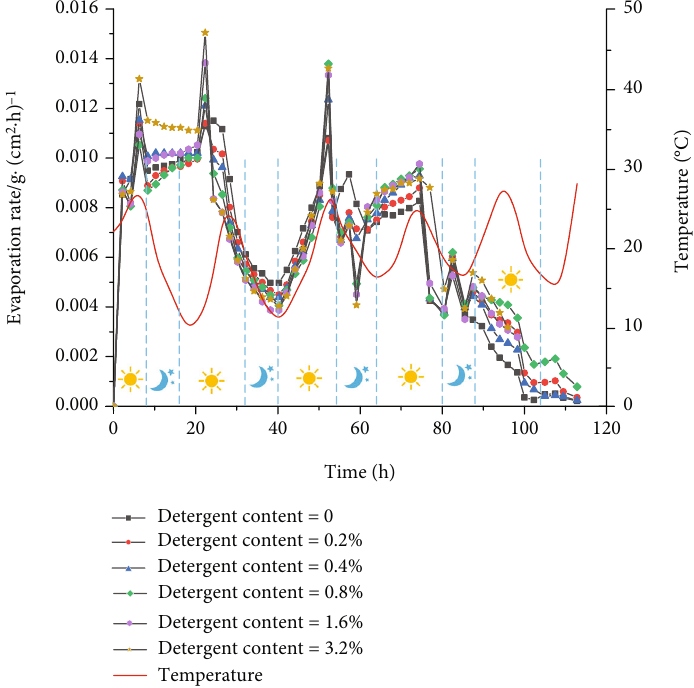
Figure 7: Changes in temperature and evaporation rate with